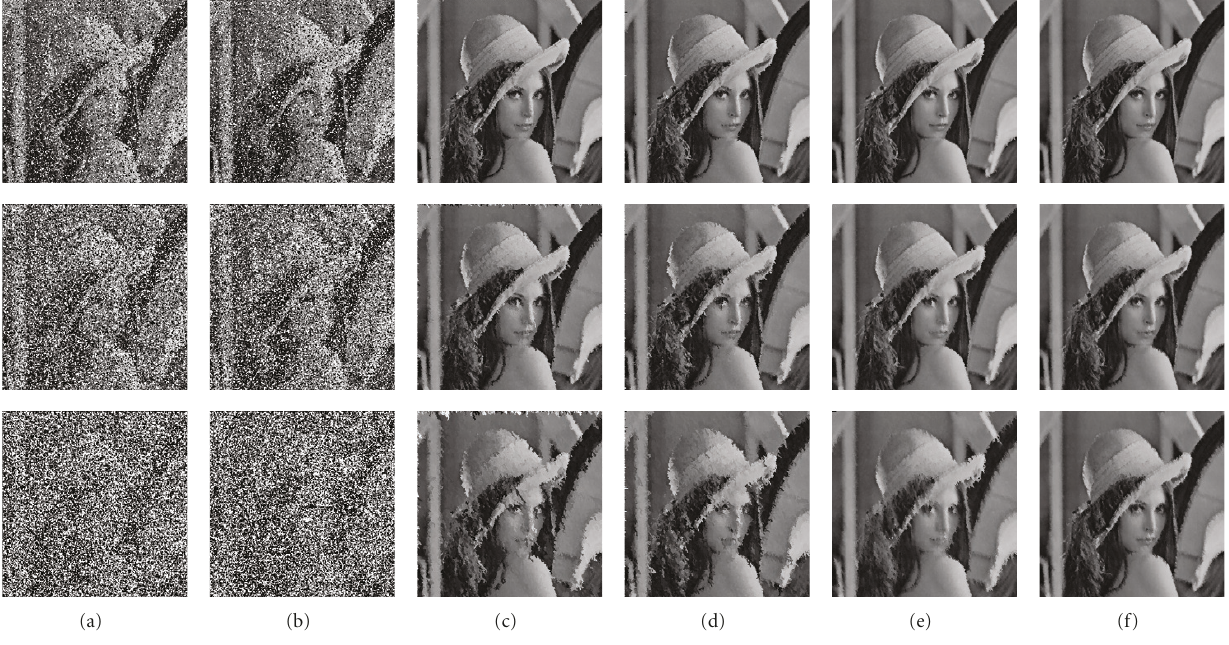
Figure 3: R esults of di ff erent filters for Lena image. (a) Output of SMF. (b) Output of PSMF. (c) Output of AMF. (d) Output of DBA. (e) Output of REMF. (f) Output of PA. Row 1–Row 3 show processed results of various filters for Lena.jpg image corrupted by 70%, 80%, and 90% noise densities.